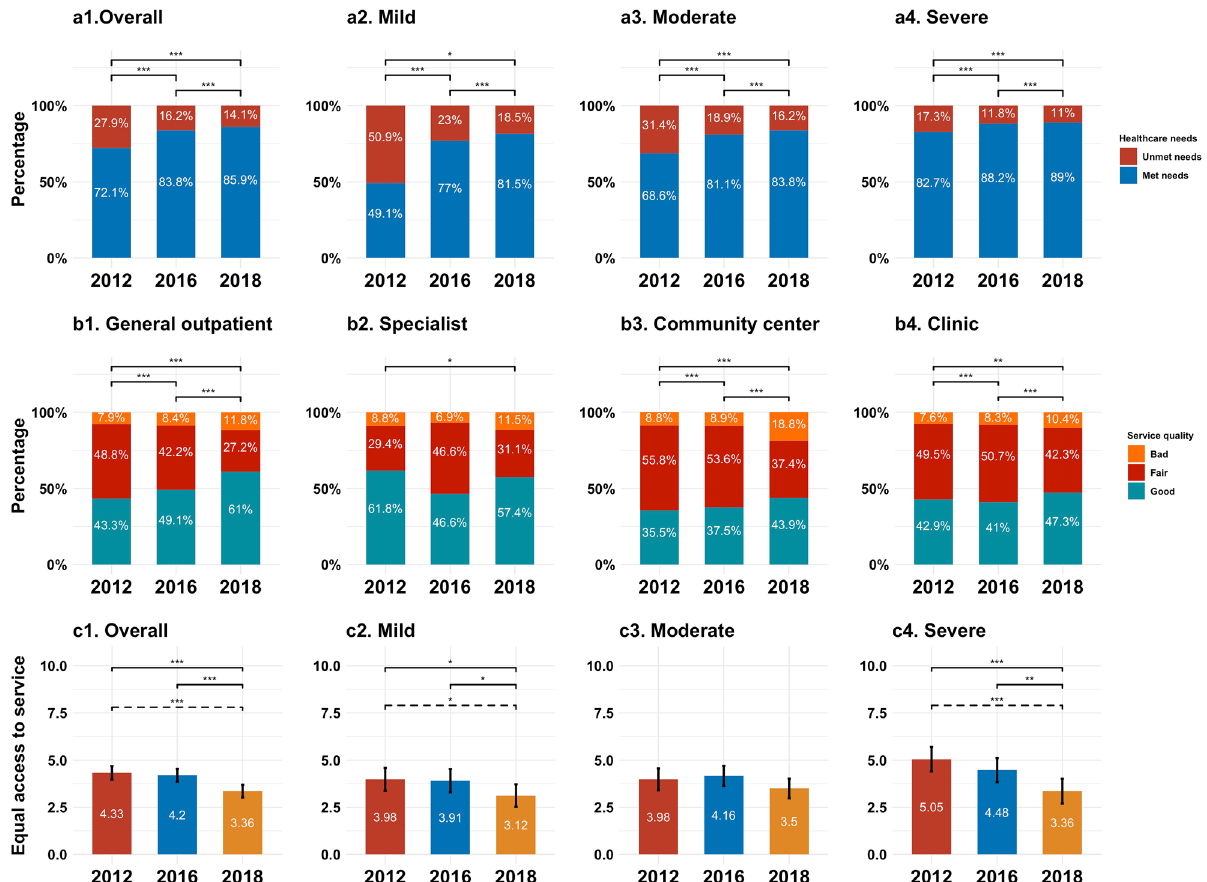
Figure 1. Association between unmet healthcare needs, severity of illness, quality of service and equal access to service, 2012–2018,